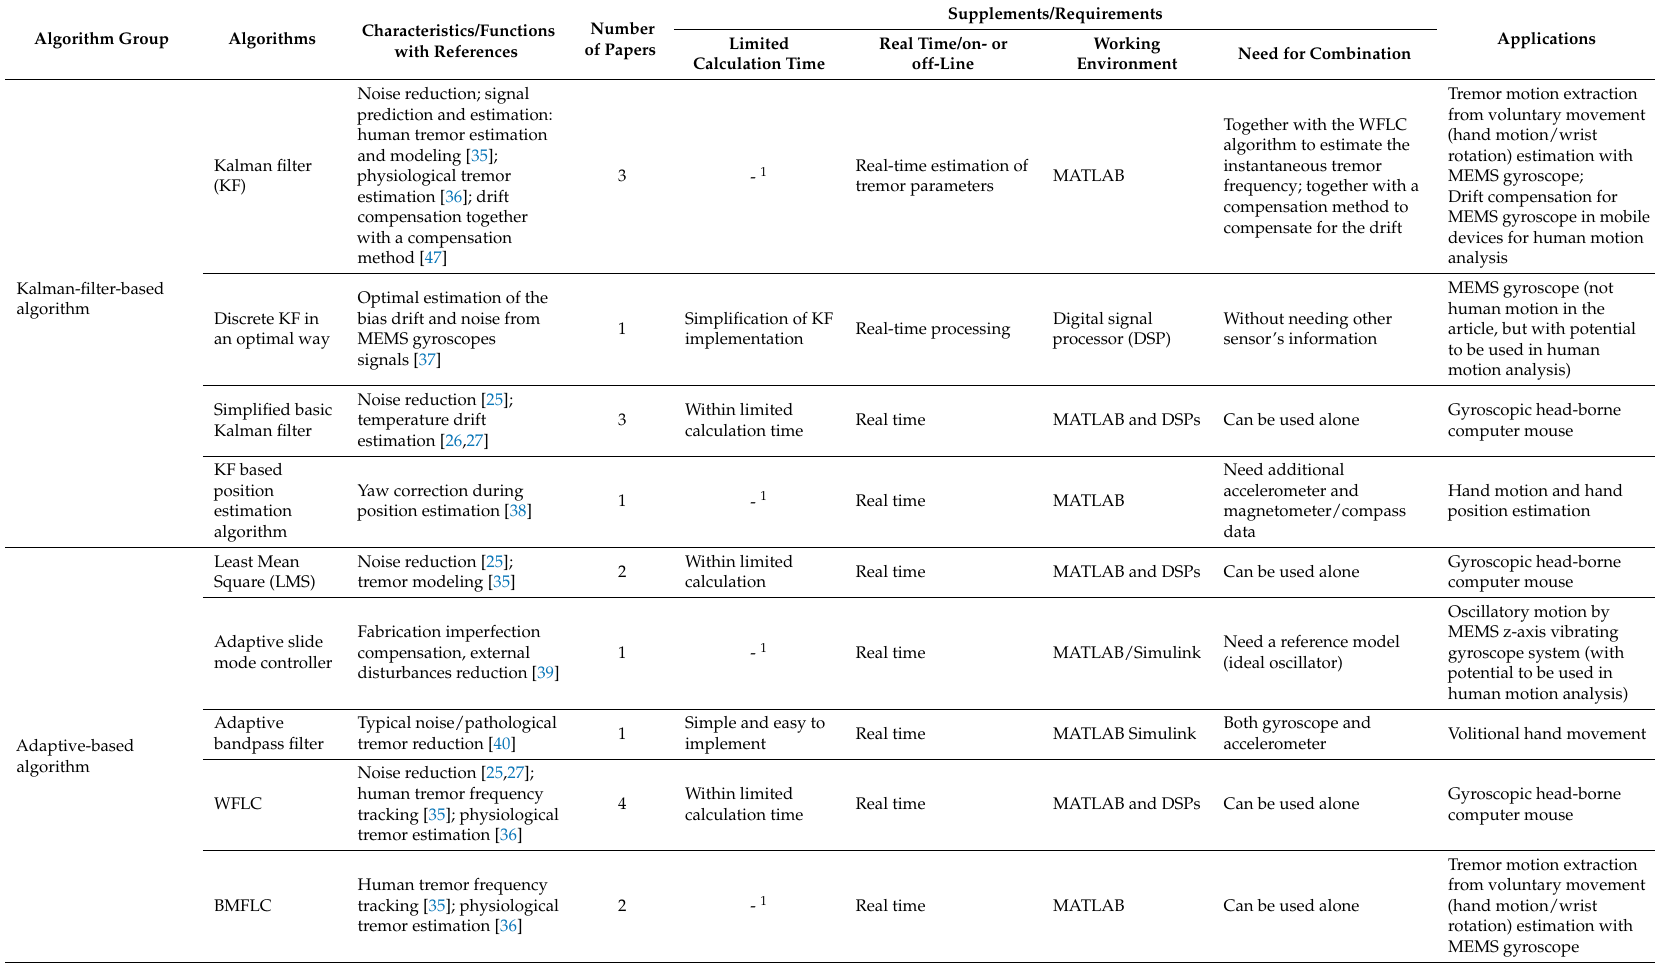
Table 1. Reviewed algorithms with